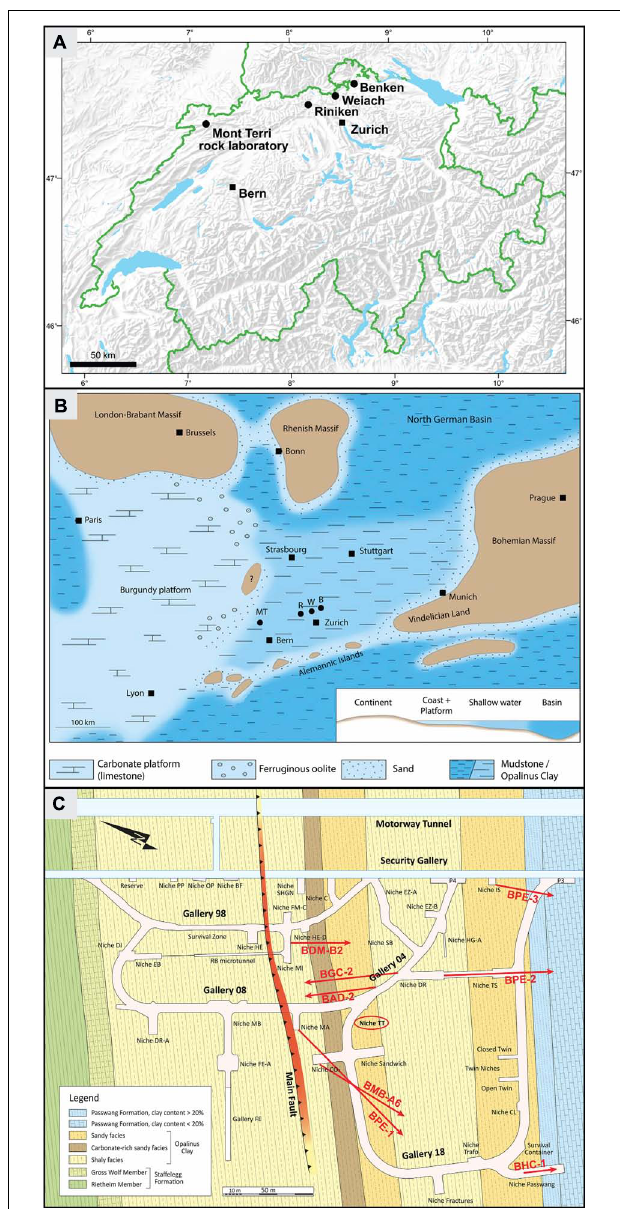
FIGURE 1 | |(A) Map of Switzerland with location of major cities (Bern and Zurich), the Mont Terri rock laboratory and the Nagra deep drillings (Riniken, Weiach, and Benken). Source: Federal Office of Topography swisstopo. (B) Paleogeographic map of the Early Aalenian in central Europe. Approximate location of major cities (squares) and study sites (circles) are indicated; MT, Mont Terri rock laboratory; R, Riniken; W, Weiach; B, Benken. A possible temporary and partial emergence of the Vosges Massif is indicated with a question mark. Modified after Nagra (2002) and based on Etter (1990); Wetzel and Allia (2000) and references therein. (C) Schematic map of the Mont Terri rock laboratory with location of the investigated drill cores indicated in red. Arrow heads point to drilling direction. The BDB-1 borehole (not indicated on the map) was drilled perpendicularly to bedding plane and crosses the entire OPA succession. The borehole begins about 9 m above the Passwang Formation, southeast along the security gallery, and ends 10 m within the top members of the Staffelegg Formation (below the rock laboratory; Hostettler et al., 2017). Source: Mont Terri